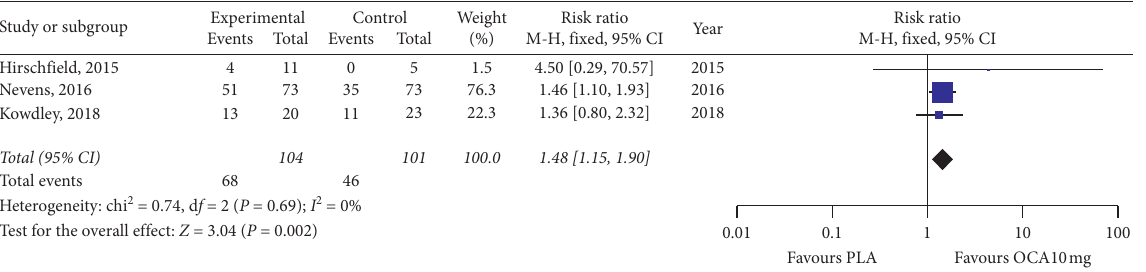
Figure 5: Effect on the overall complete response in patients with PBC treated with OCA versus